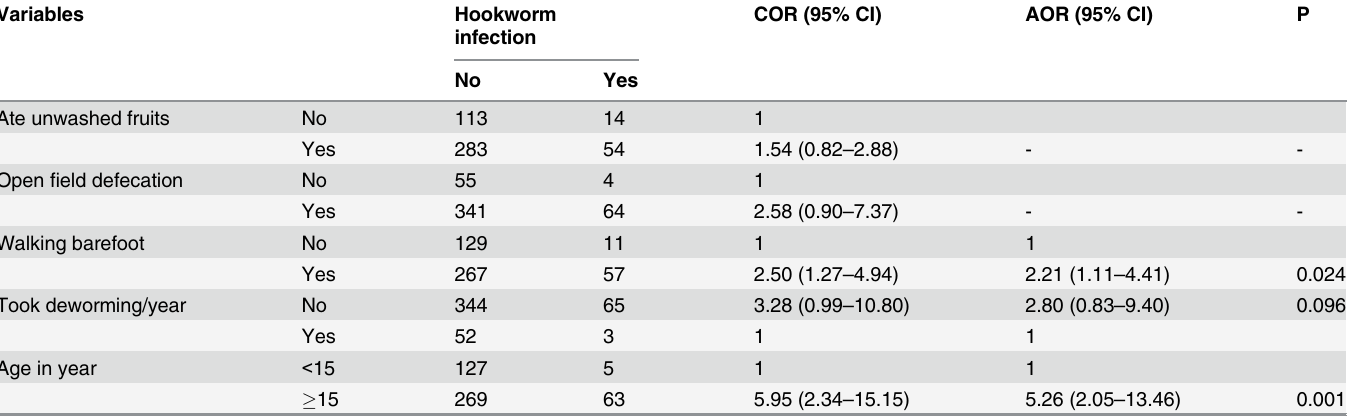
Table 2. Determinant factors for hookworm infection among clients attending at Anbesame health center, 2015. Variables